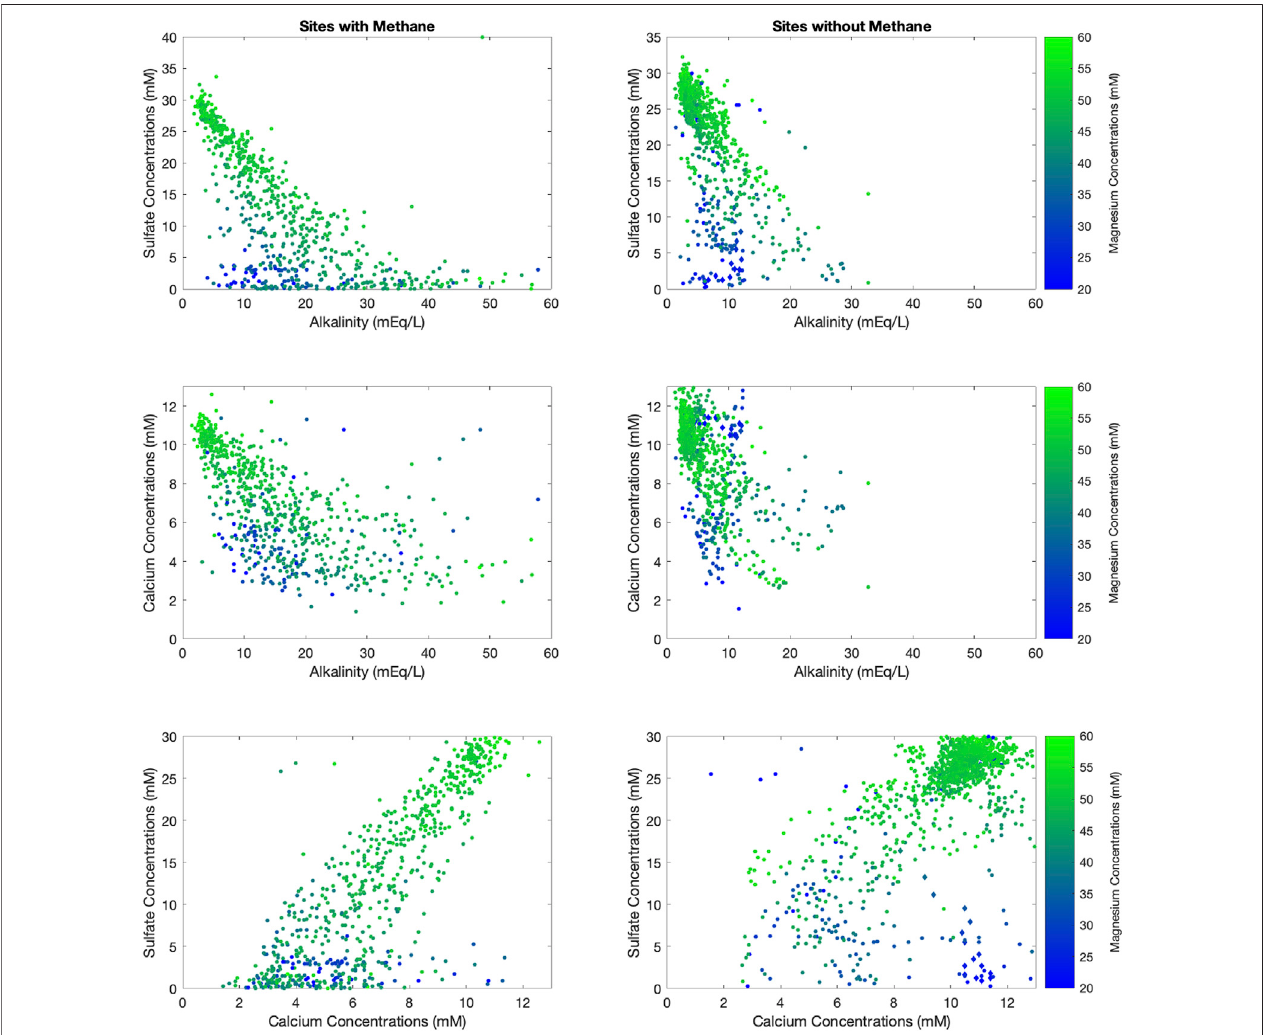
FIGURE 4 | Cross plots of sulfate vs. alkalinity (top row), calcium vs. alkalinity (middle row) and sulfate vs. calcium (bottom row) with the data color-coded by the concentration of pore fl uid magnesium. The data are split into sites that have methane (left column) vs. sites that do not (right column).